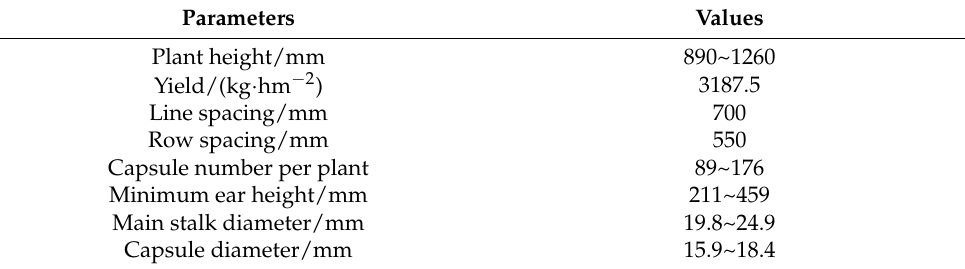
Table 1. Planting and plant characteristic parameters of